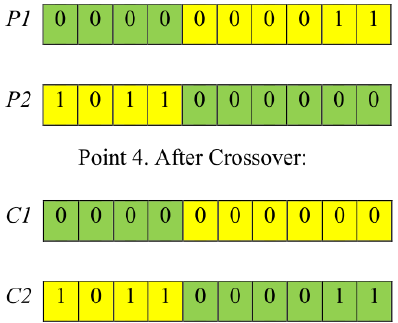
Figure 3. Example of the ineffective one-point crossover.